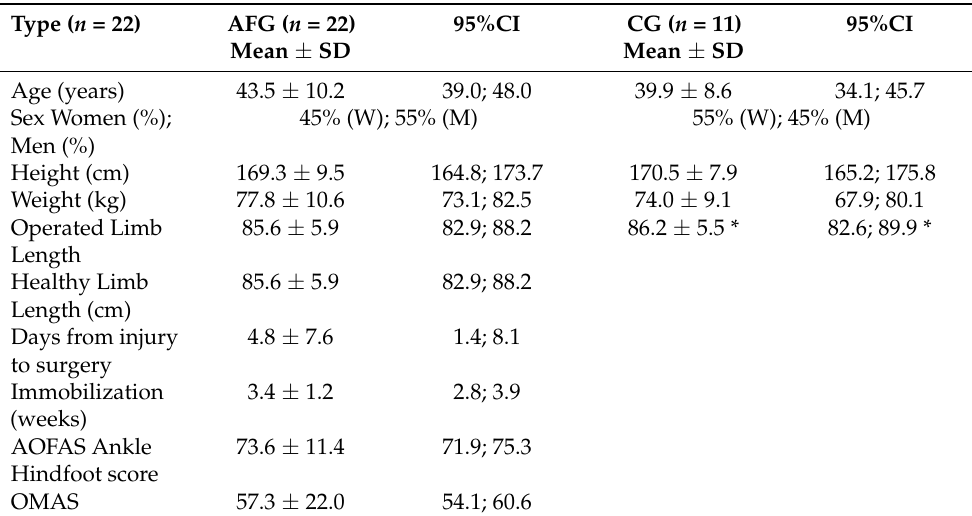
Table 1. Demographic, anthropometric, and functional characteristics of patients with bimalleolar ankle fractures 6 months after surgery and the control group.